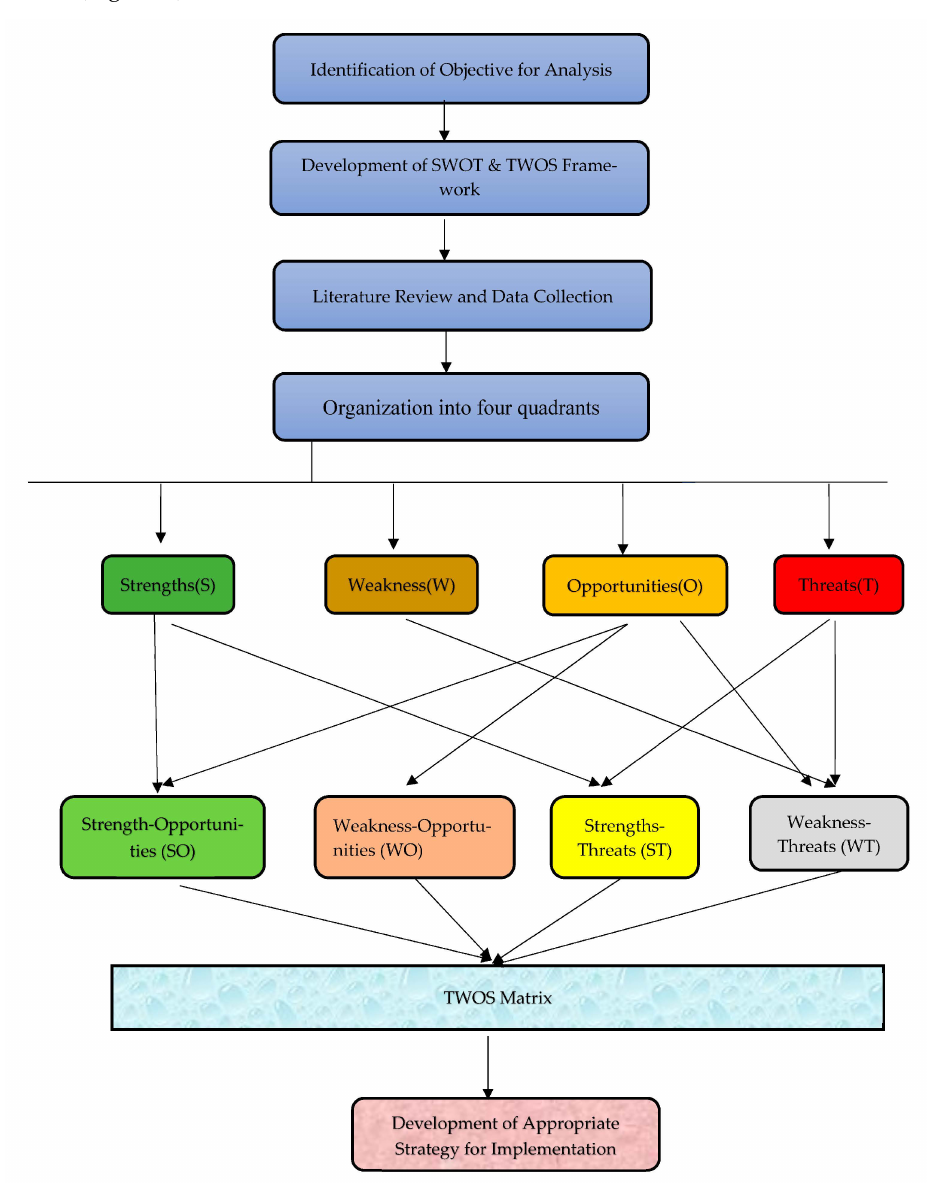
Figure 2. SWOT analysis framework of agrivoltaic